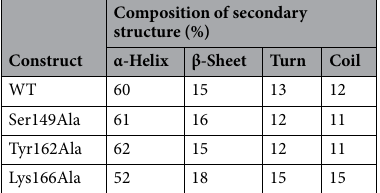
Table 5. Secondary structure contents of BPSS2242, WT and mutants.